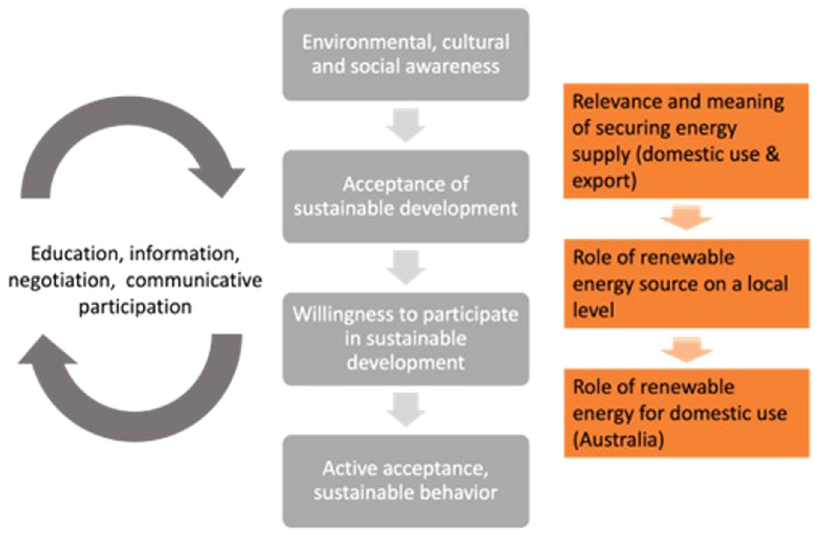
Fig. 1 Role of sustainability knowledge and information provision on acceptance